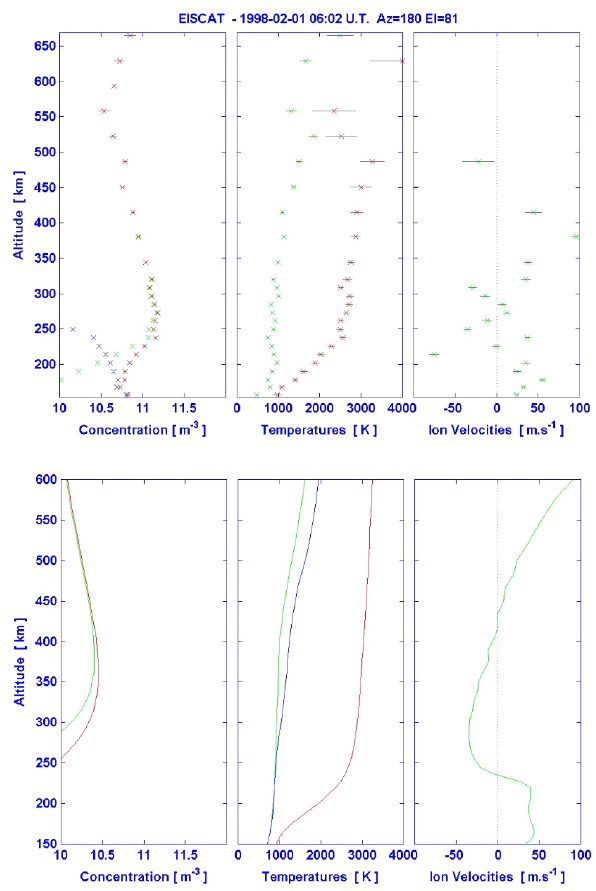
Fig. 10. Measured (top panels) and modelled (bottom) altitude pro- files of the plasma parameters within an ion-heating event (electrons in red, H + in green, molecular ions in